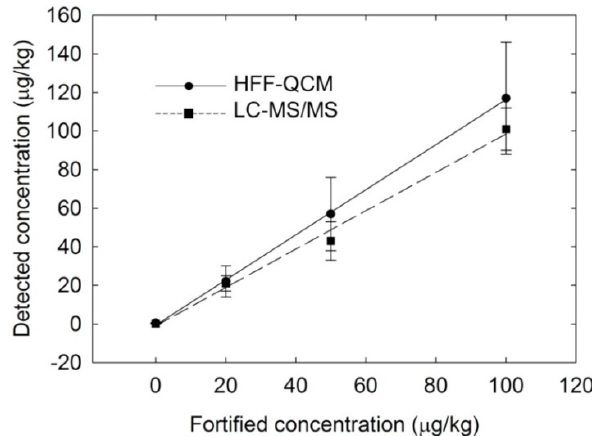
Figure 4. Analysis of the fortified honey samples by HFF-QCM sensor and LC-MS, the correlation